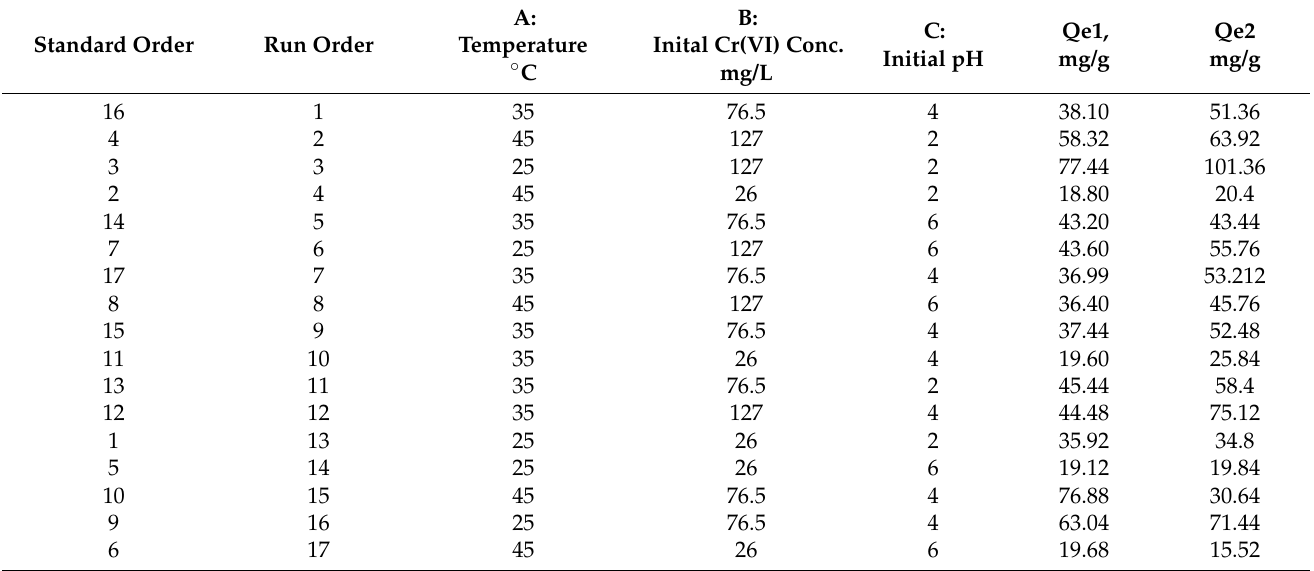
Table 2. FC-CCD experimental variables and results for CoAl-LDH (Qe1) and bentonite-CoAl-LDH